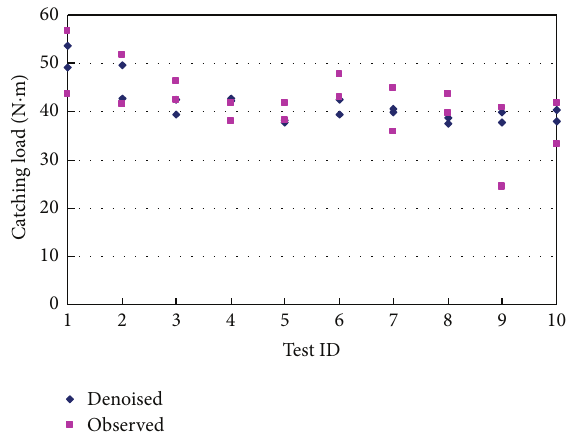
Figure 8: Catching load comparisons of observed signal and denoised